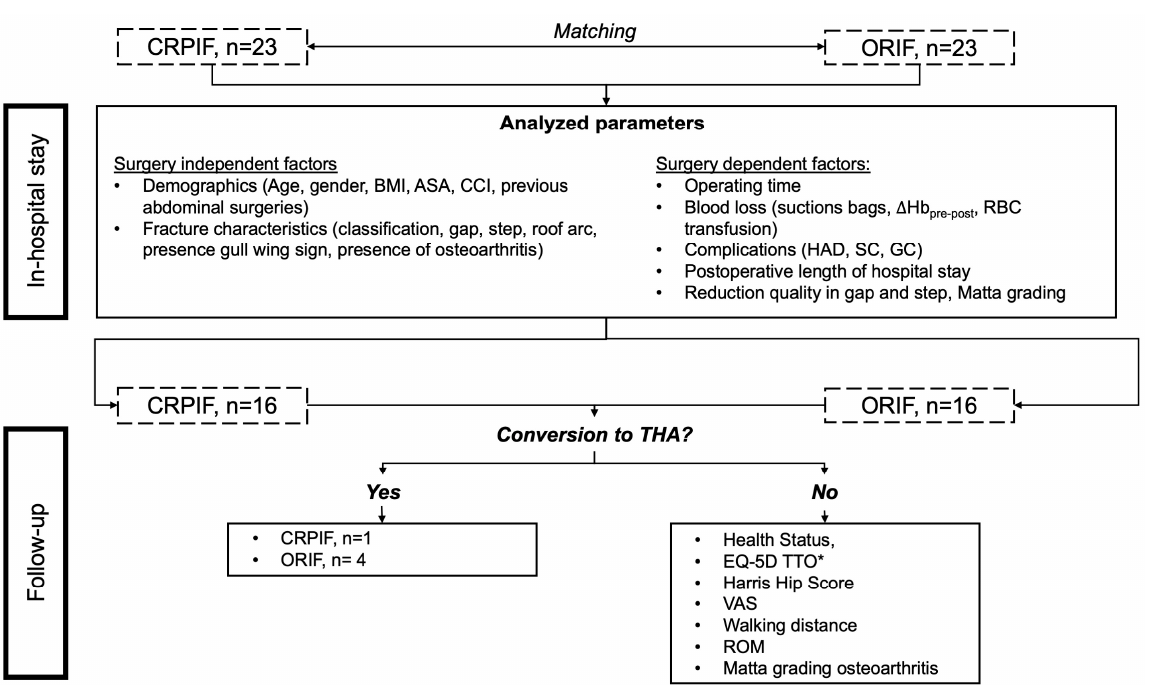
Figure 1. Protocol of the investigation. After matching closed reduction and percutaneous internal fixation (CRPIF) patients to open reduction and internal fixation (ORIF) patients, the presented in-hospital data were obtained. Afterward, patients were asked to participate in the follow-up examination. Patients who received total hip arthroplasty (THA) after one postoperative year were noted. If patients received no THA, the functional outcome and quality of life were assessed using the presented instruments. * Two patients refused to fill out the EQ-5D TTO. Body mass index, BMI; American Society of Anesthesiologists grading, ASA; Charlson Comorbidity Index, CCI; difference between pre- and postoperative hemoglobin concentration, ∆ Hb pre-post ; red blood cell, RBC; hospital- acquired death, HAD; surgical complications, SC; general complications, GC; visual analog scale, VAS; range of motion,